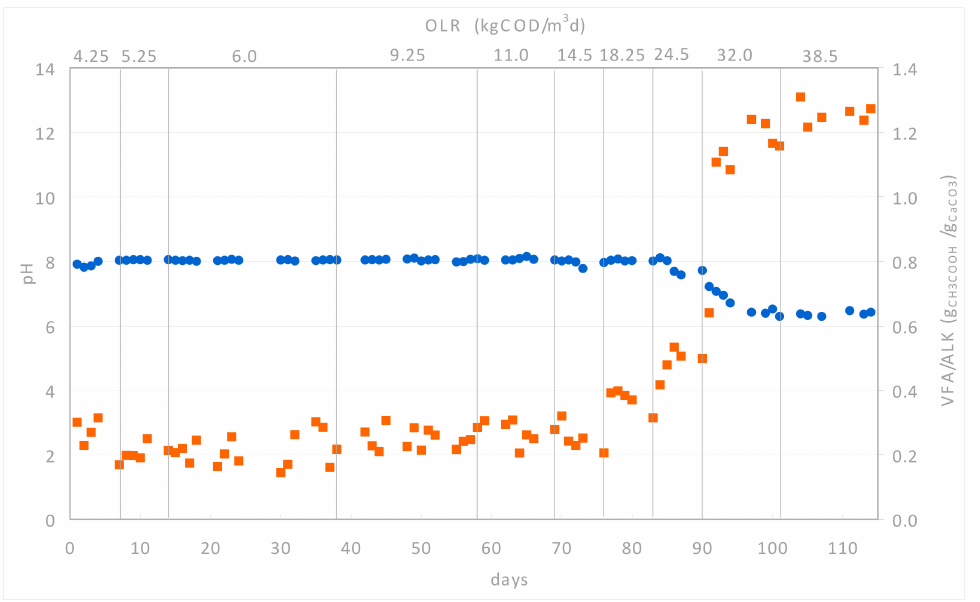
Figure 5. pH and VFA / ALK over the pilot plant operational